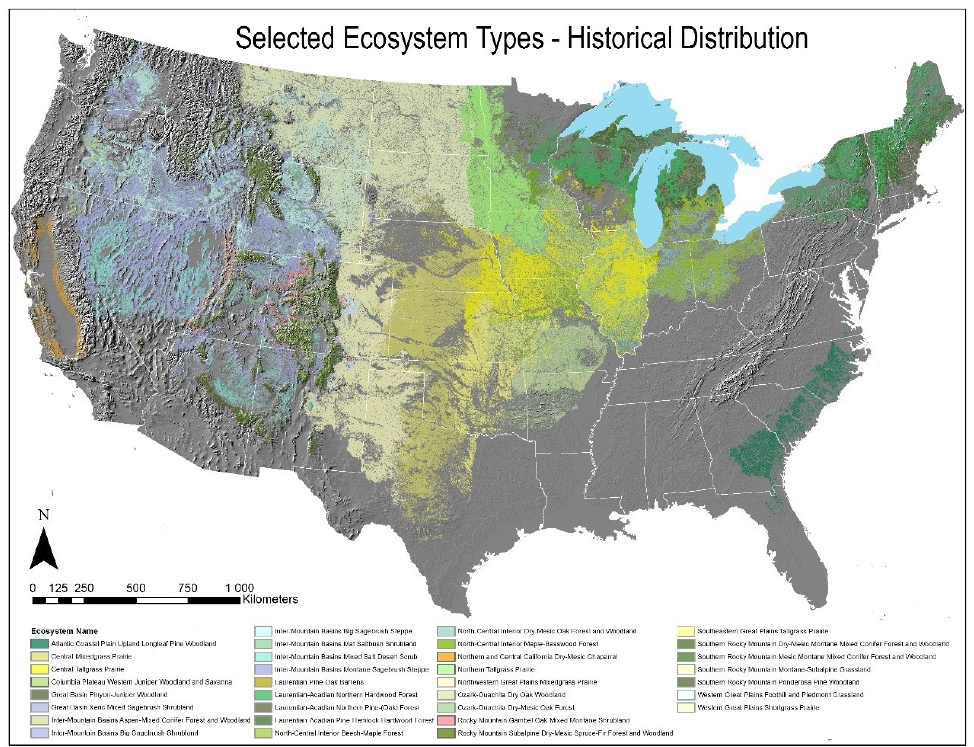
Figure 1. Mapped distributions of 33 upland ecological system types in the conterminous USA.